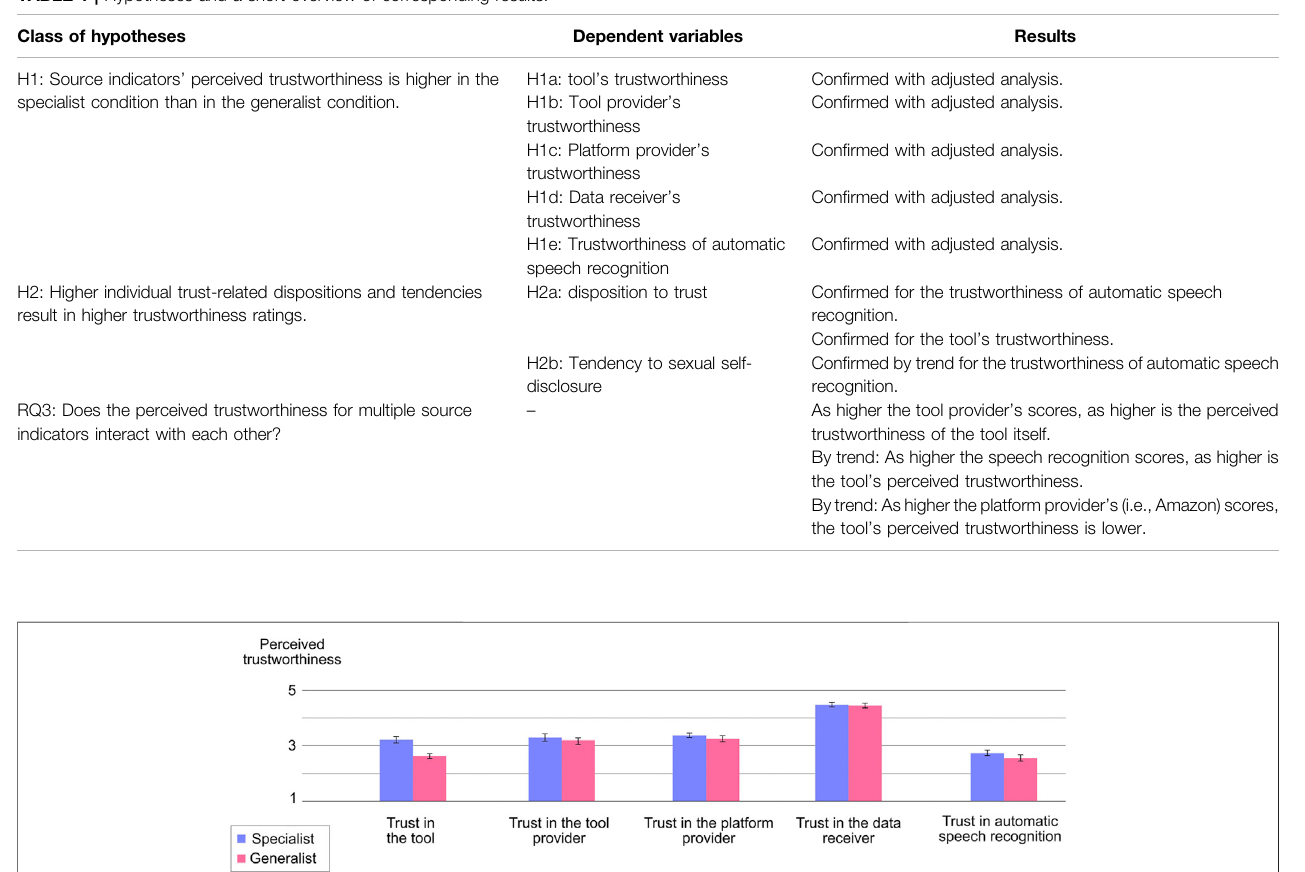
TABLE 1 | Hypotheses and a short overview of corresponding results.